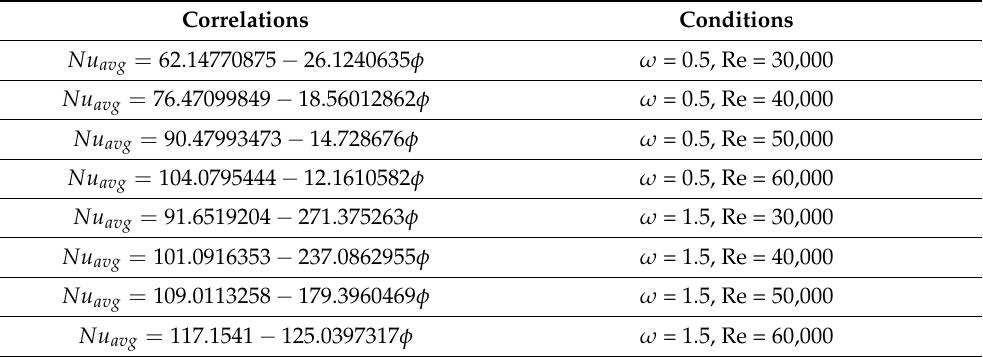
Figure 6. The average Nusselt number against increasing volume fractions with ω = 3.5: ( a ) Re = 30,000, ( b ) Re = 40,000, ( c ) Re = 50,000, and ( d ) Re = 60,000. Table 5 details several correlations made with the present data. Table 5. Correlations for average Nusselt number against the increasing volume fraction of water alumina nanofluid.